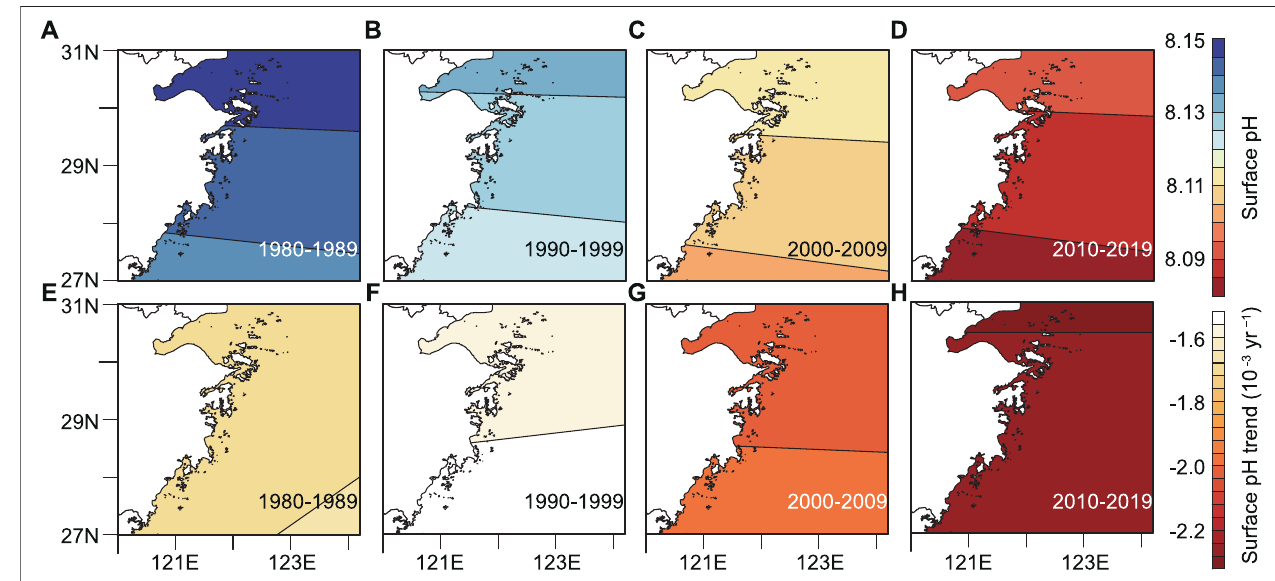
FIGURE 7 | (A) Prescribed atmospheric CO 2 concentration and model-simulated time series of annual mean (B) cumulative oceanic CO 2 uptake, sea surface (C) temperature, and (D) pH in Zhejiang offshore. Results are shown for the four simulations using the four RCP scenarios depicted in the Data and Modeling section.